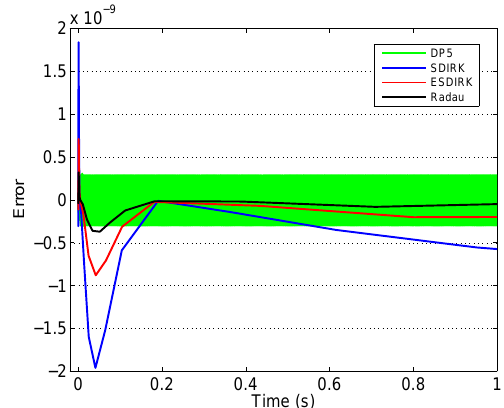
Fig. 6: GABA R model open state concentration A solution